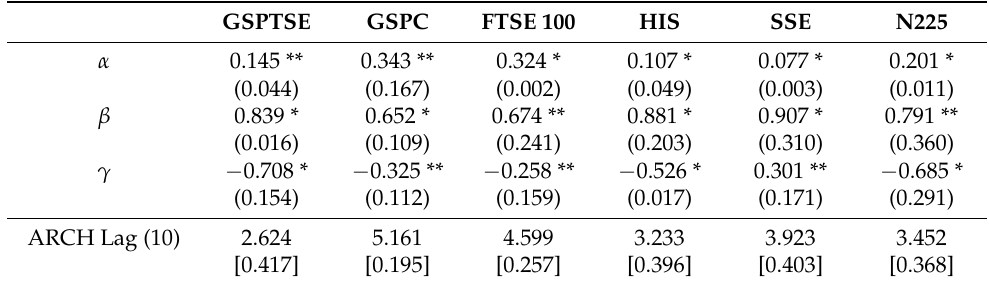
Table 1. Estimation results of the single-equation models for the stock market indices under consid- eration before the COVID-19